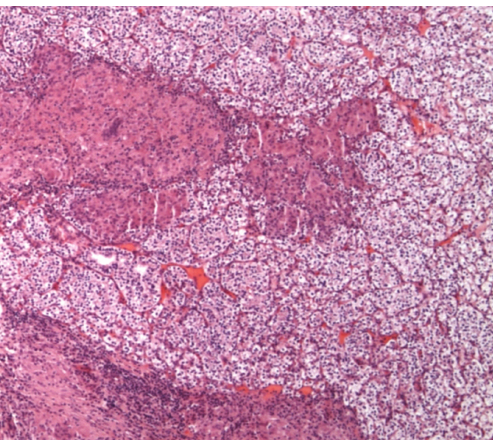
Figure 1: Conventional renal cell carcinoma of clear cell type with Fuhrman grade II nuclei and associated multiple granulomas (40x magnification).